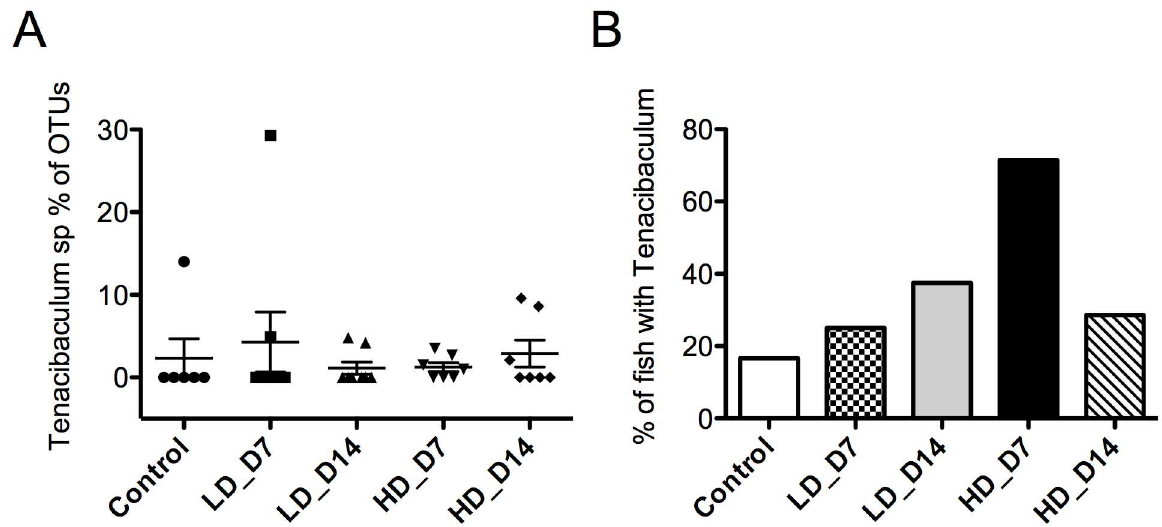
Fig 7. SAV3 infection results in increased abundance of Tenacibaculum sp . A) Percentage of total OTUs represented by Tenacibaculum sp . in control and SAV-infected groupsB) Percentage of fish containing Tenacibaculum sp . in their skin bacterial community in control and SAV-infected groups. LD_D7: low-doseinfected day 7; LD_D14:low-doseinfected day 14; HD_D7: high-doseinfected day 7; HD_D14:high-dose infected day